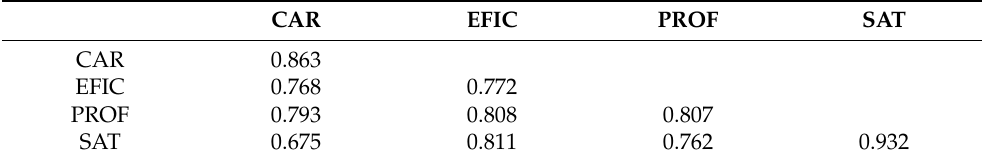
Table 4. Discriminant validity of measures.